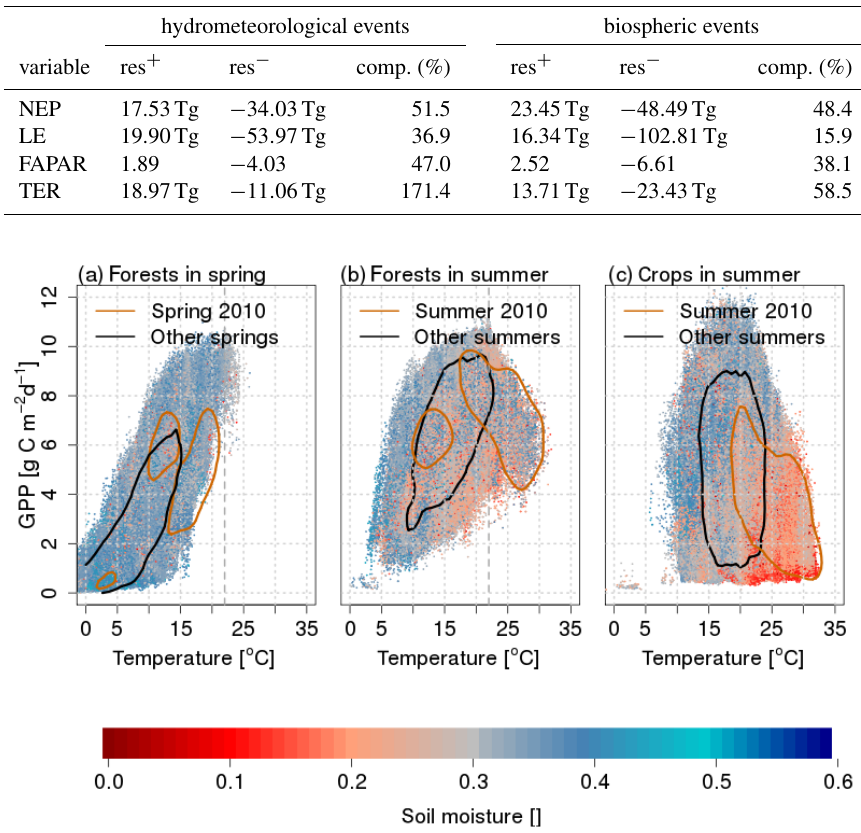
Figure 8. Temperature optimality for GPP in (a) forests during spring, (b) forests during summer, and (c) crops during summer. Contour lines enclose 75% of the data